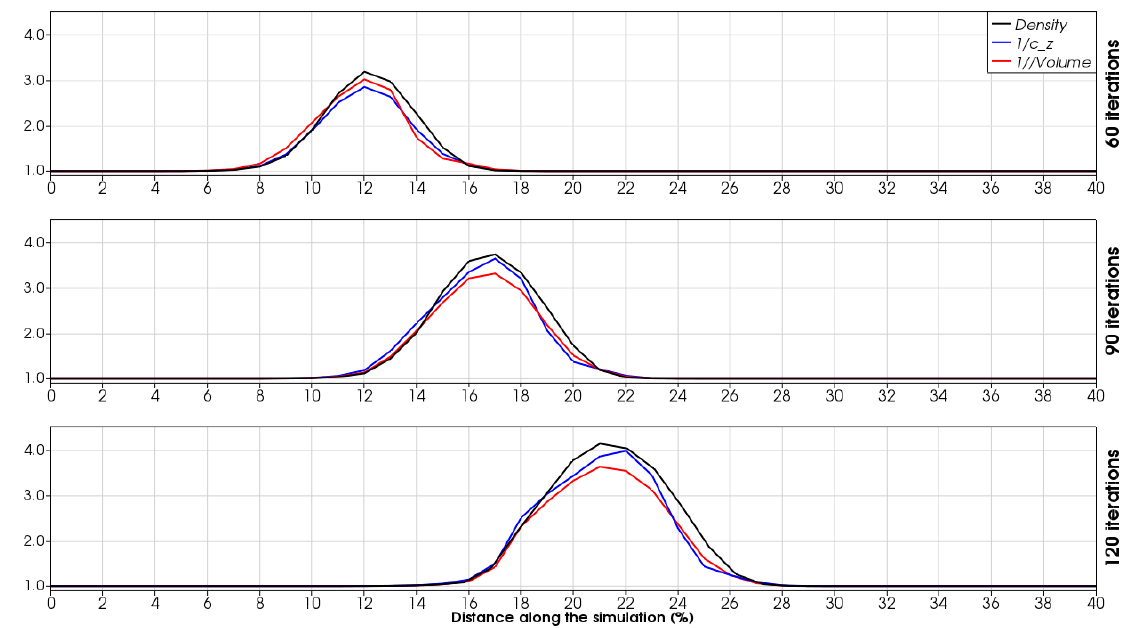
Figure 1. The density profile for a planar shock simulation is shown for three epochs of evolution: after ( Top ) 60 iterations, ( Middle ) 90 iterations, and ( Bottom ) 120 iterations. The density as obtained from the Euler equations (black line), as calculated from the inverse of the total parallelepiped volume (blue line), and the density calculated from the inverse of the initially shock-normal parallelepiped vector component (red line) are shown for three epochs of the